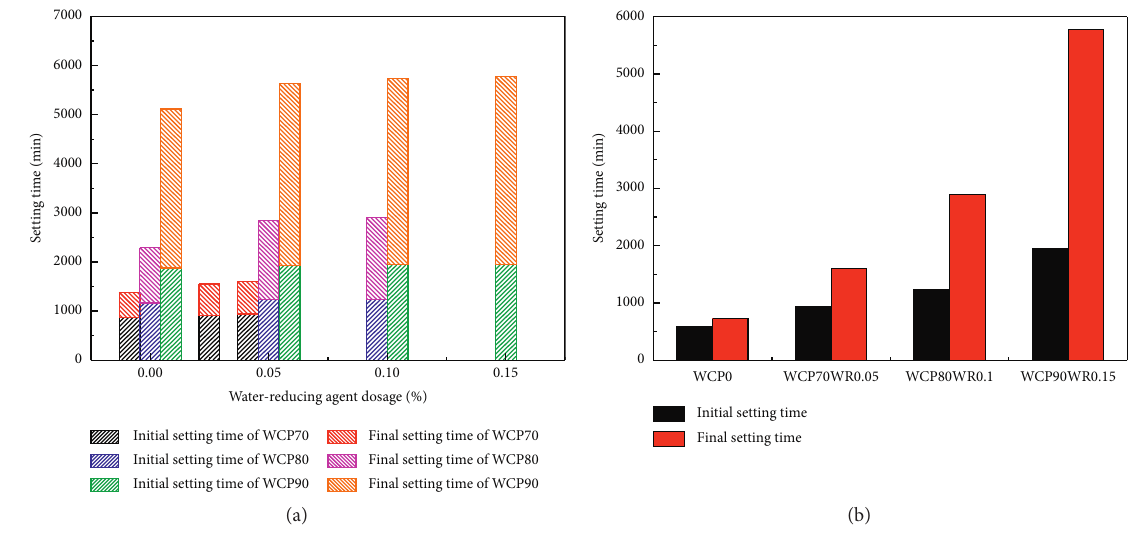
Figure 11: Setting time after adding water-reducing agent: (a) change rule and (b) comparison of slurries with similar